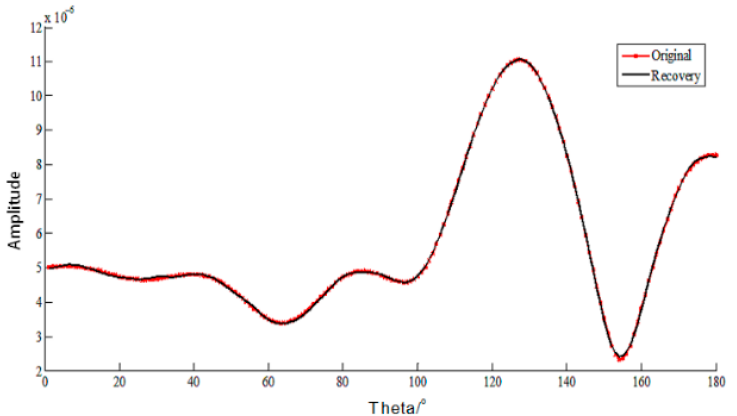
Figure 4. The current of PEC cube by multilevel fast multipole acceleration (MLFMA) and MLFMA with compressive sensing (CS) based on DCT basis.